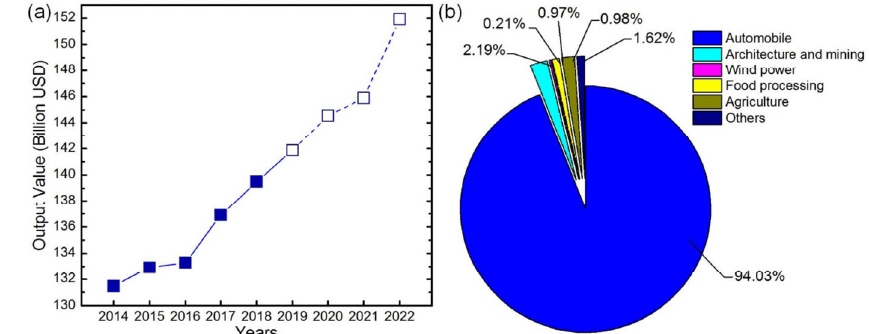
Fig. 7 (a) Global gearbox output value and (b) distribution of production quantities of gearboxes in different